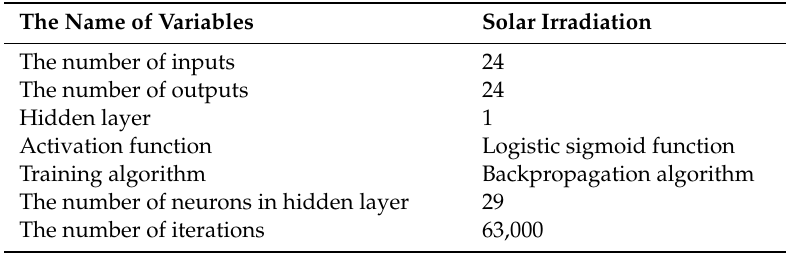
Table 6. Parameters of ANN designed for solar irradiation forecasting.